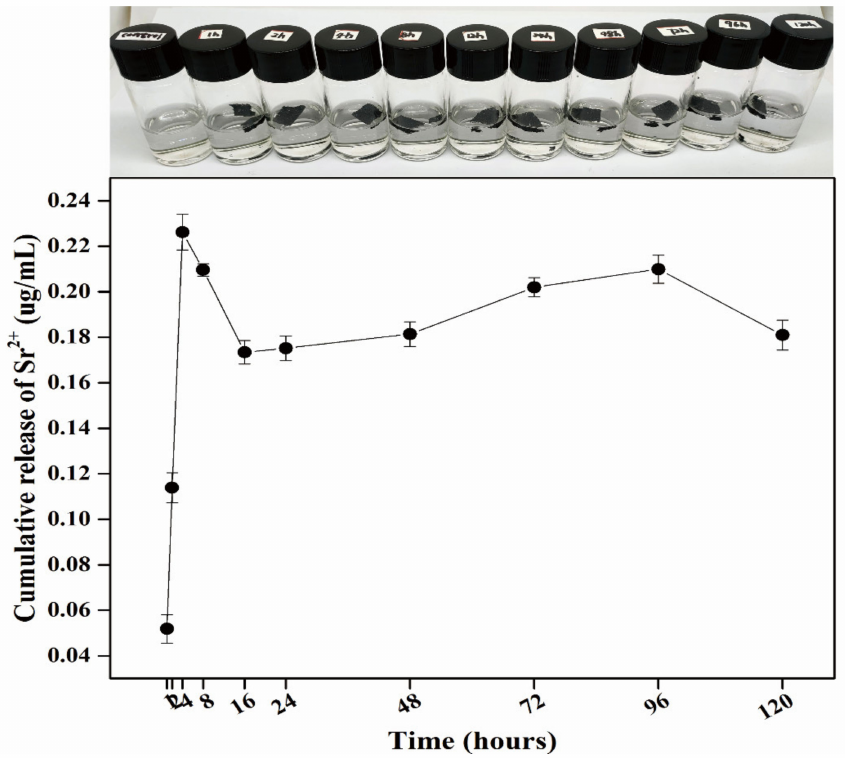
Figure 8. Optical image of 3D rGO/PPY/Sr scaffolds were immersed in 5 mL of PBS (the first row). Release of the Sr ions from the 3D rGO/PPY/Sr (the second row)